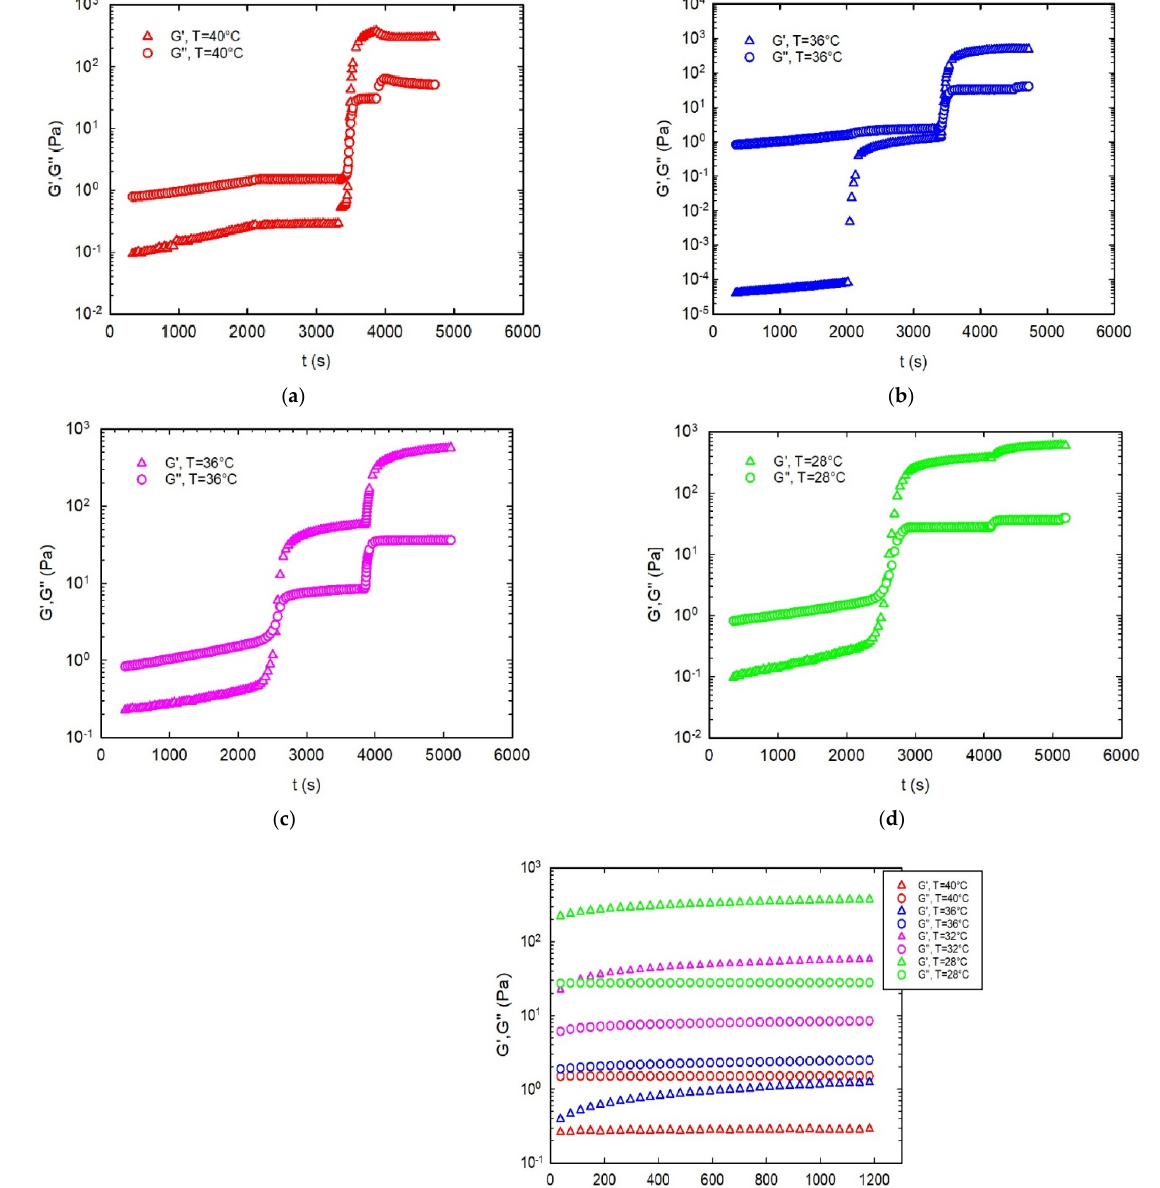
Figure 7. The complex modulus of the kC bio-ink as a function of time for the thermal history reported in Figure 6, and for different extrusion temperatures: ( a – d ) The total temperature history; the four regions correspond to the thermal changes reported in Figure 6 (see text for details). ( e ) A close-up of region III.